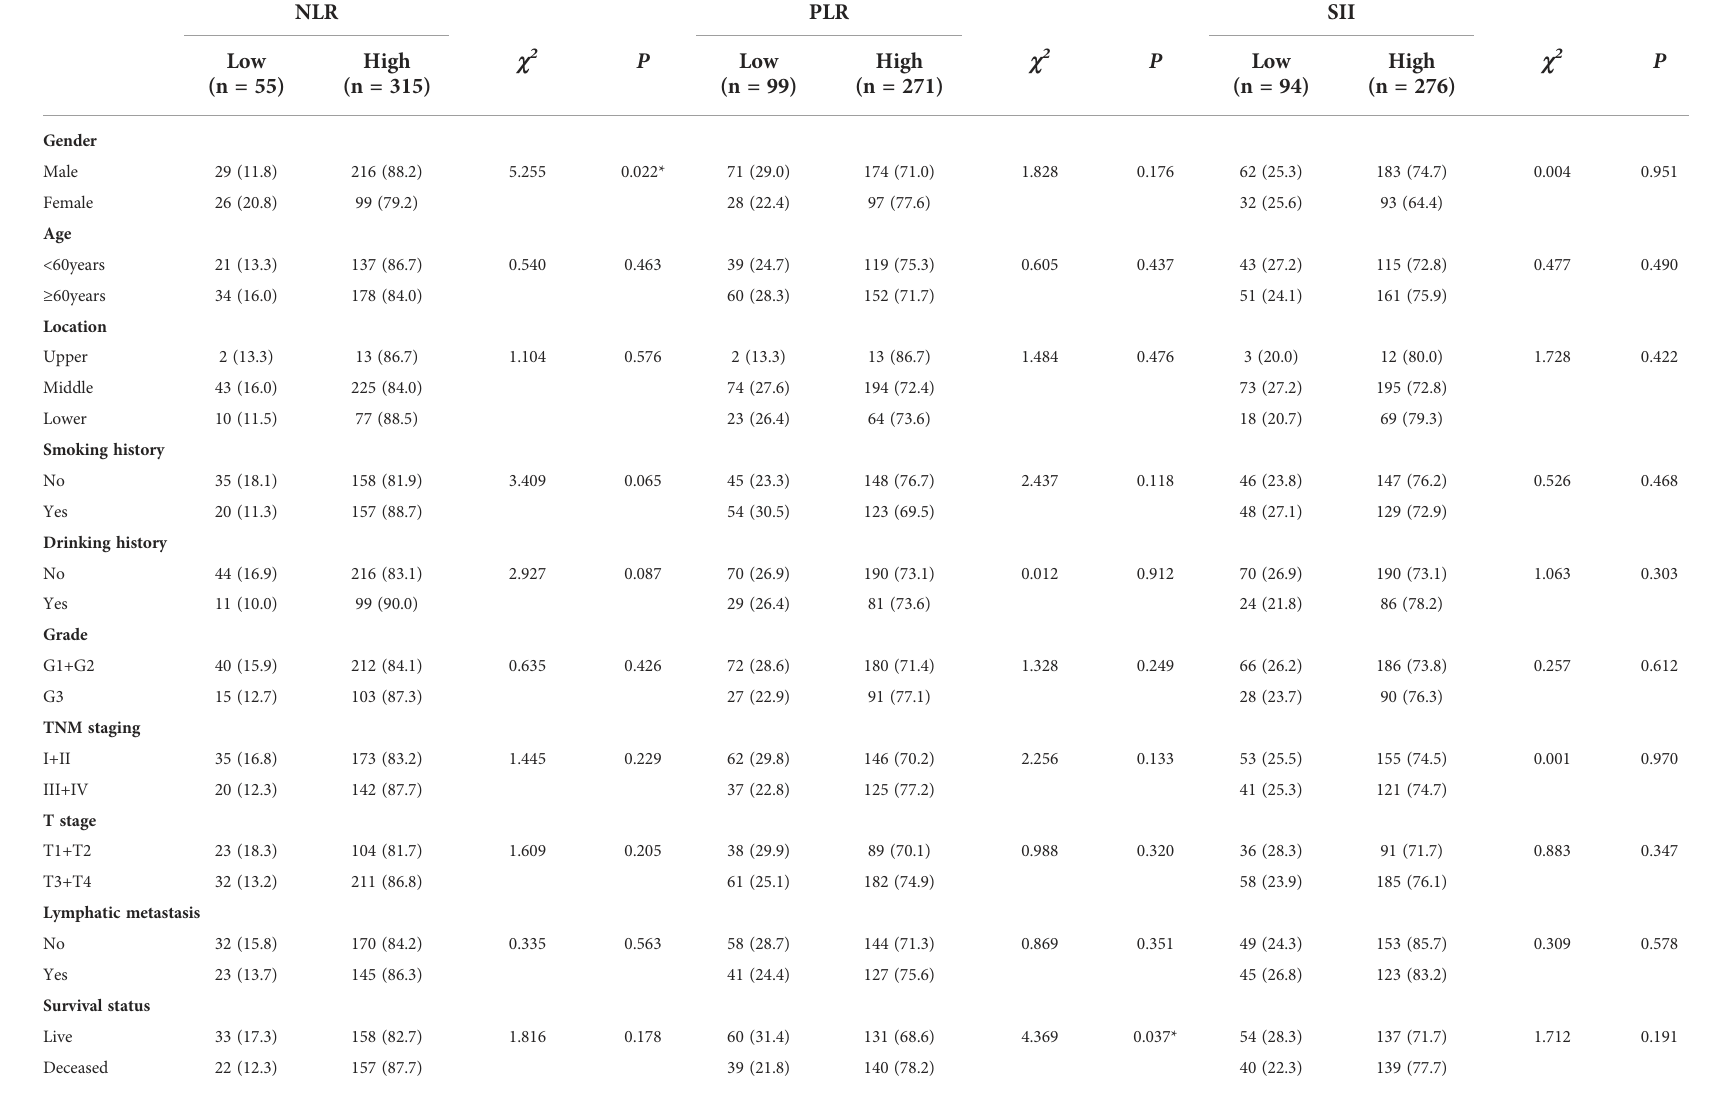
TABLE 2 The relationship between in fl ammatory parameter and clinical pathological